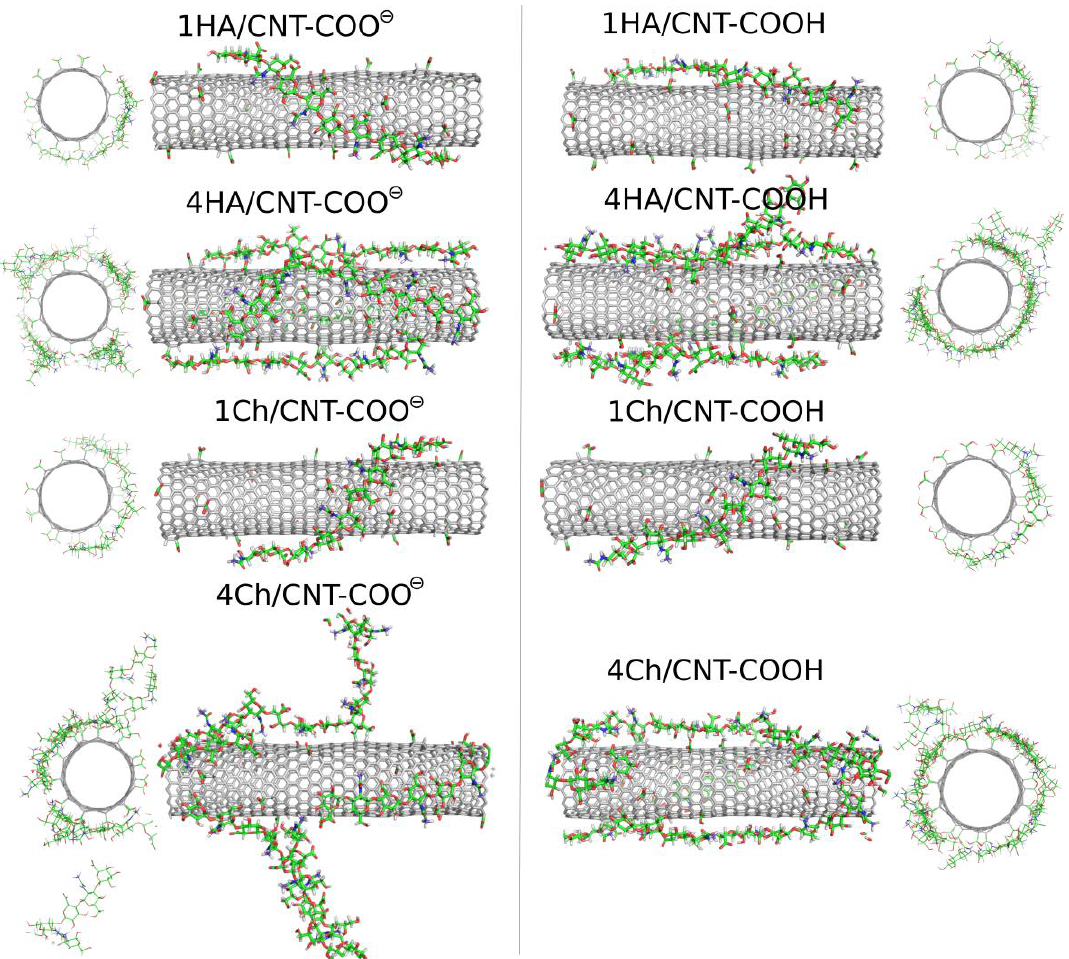
Figure 6. MD simulation snapshots for molecular systems involving the HA and Ch oligosaccharides: HA (one or four HA molecules) and Ch (one or four Ch molecules) adsorbed on the CNT-COOH and CNT-COO (cid:9)